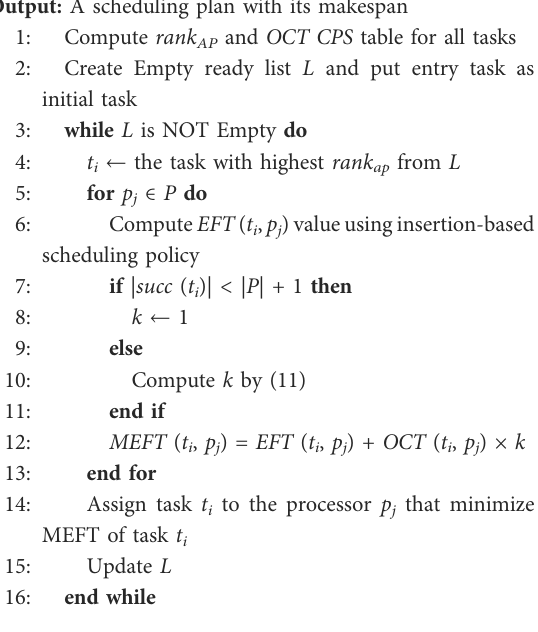
Algorithm 2. The MPEFT Algorithm